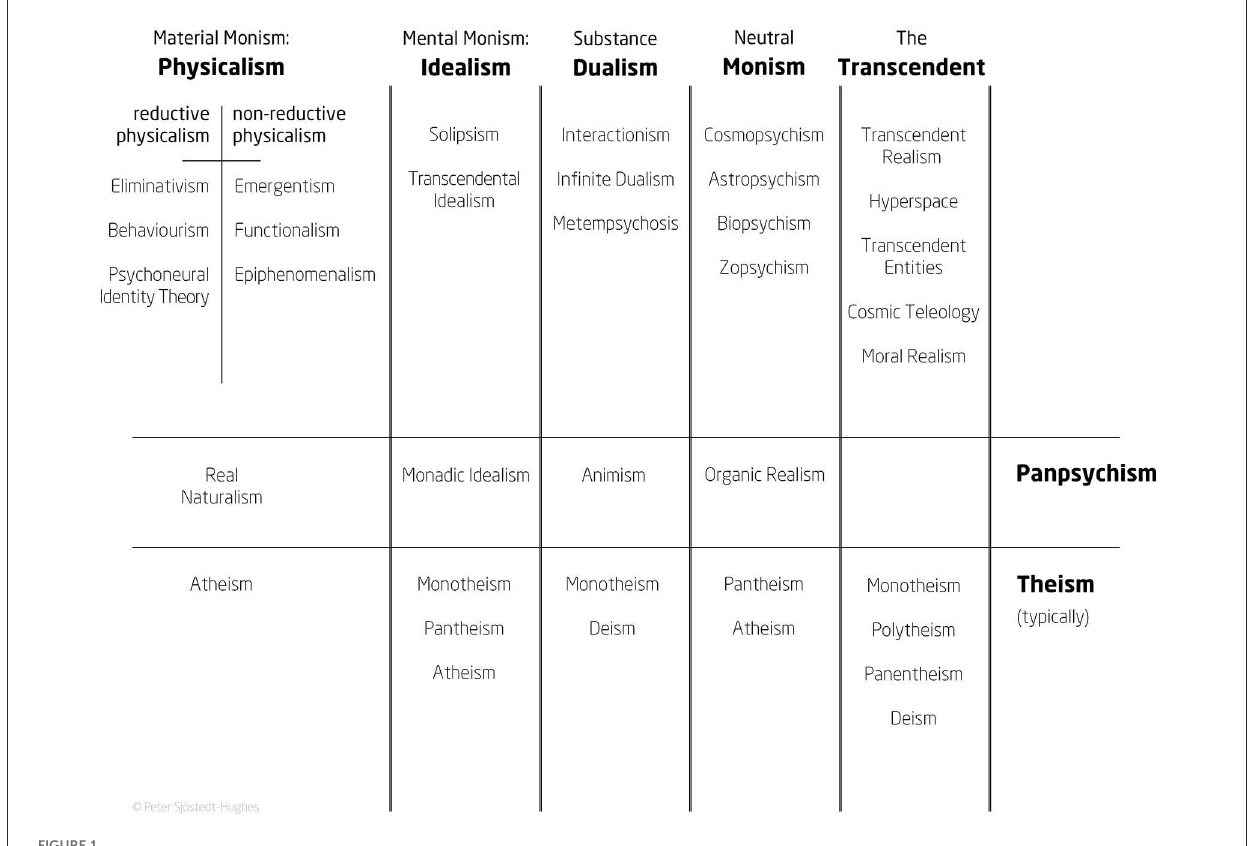
FIGURE1 Metaphysics Matrix.